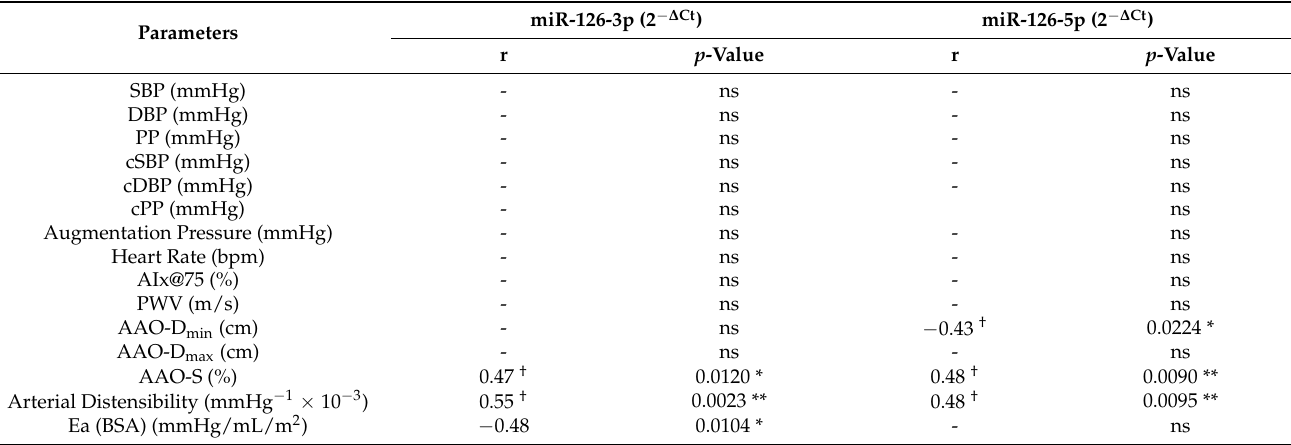
Table 2. Correlation of miR-126-3p/5p with vascular parameters in Turner Syndrome patients (TS)